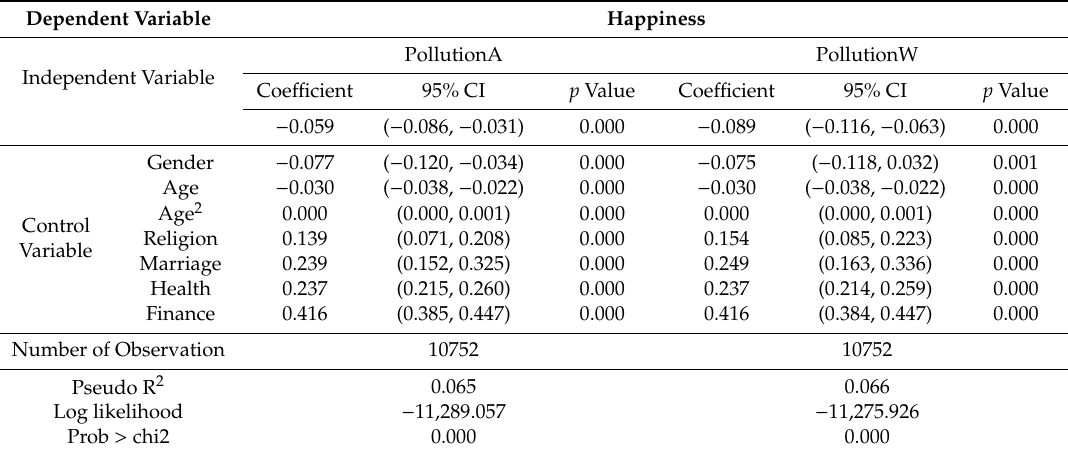
Table 3. Regression results of environmental pollution e ff ect on residents’